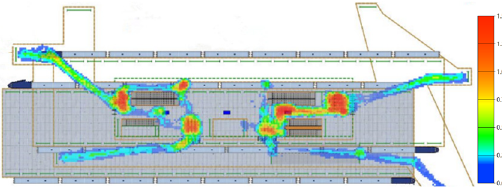
Figure 16. Scenario of 70% male evacuation.